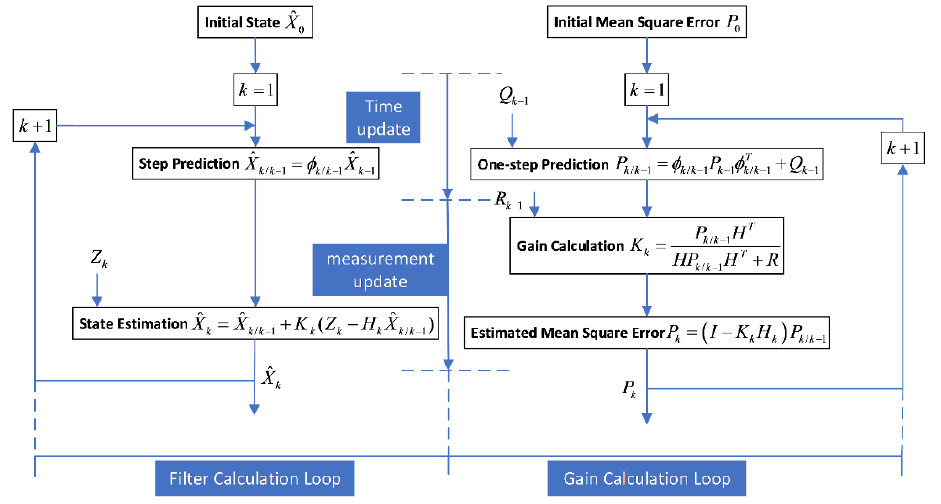
Figure 3. The flow chart of the Kalman filter. At each calculated step size, the Kalman algorithm runs in two steps: time updating and measurement updating. The time-update step predicts the navigation states vector and its covariance matrix by propagation through a model of the system dynamics. The measurement-update uses the data from the sensors and is incorporated to correct the prediction and output an optimal estimation by calculating the optimal Kalman gain. The system error state can be estimated by the Kalman filter, then the system error can be corrected by closed-loop feedback.